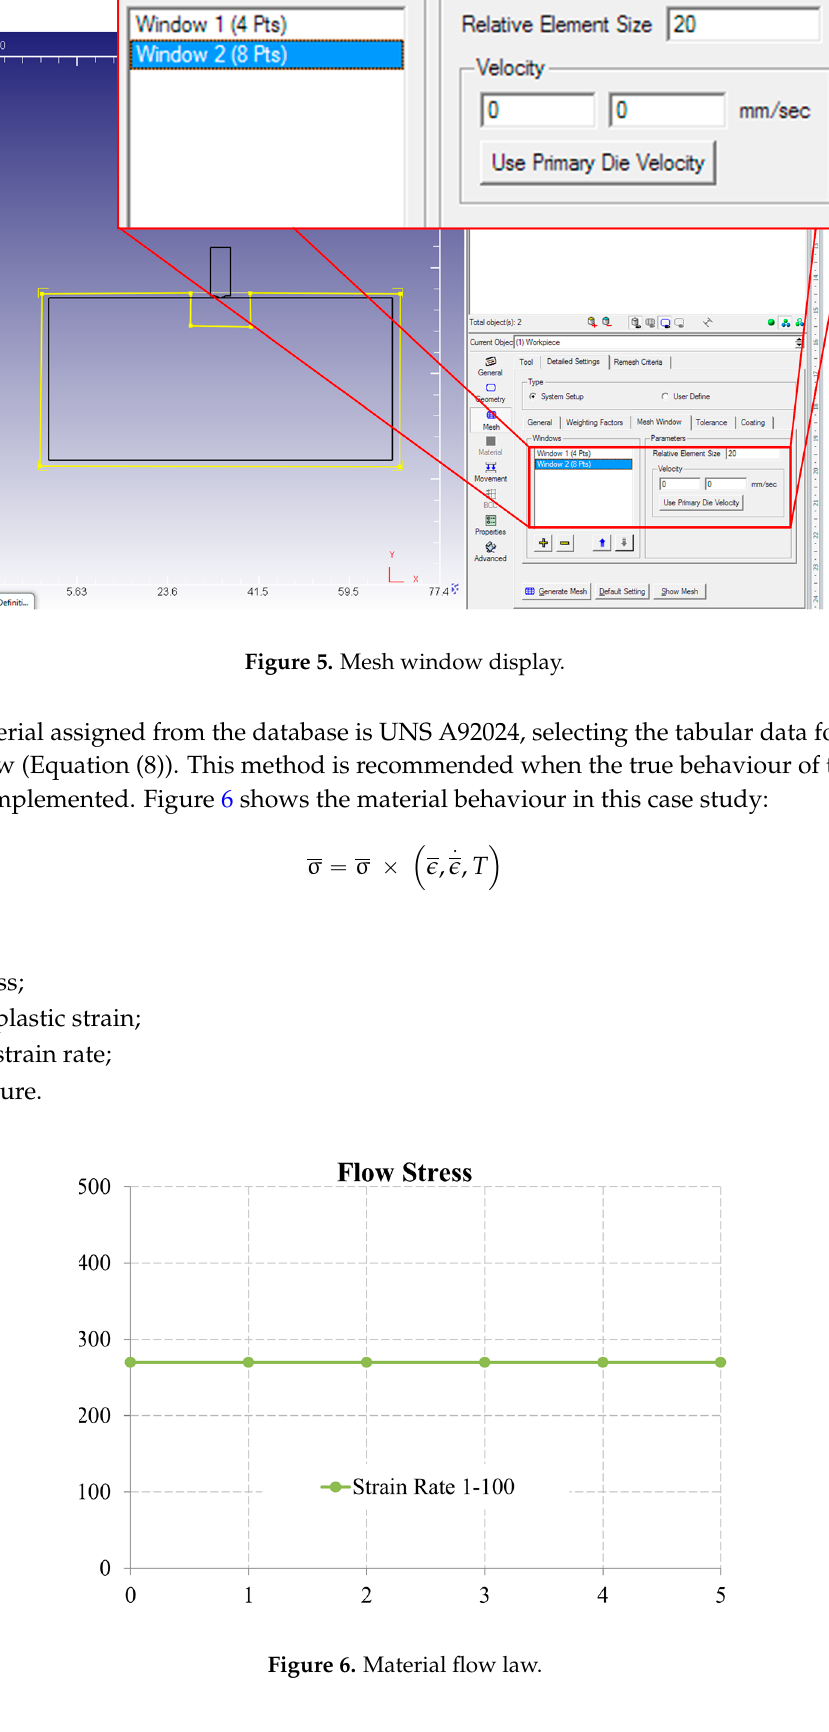
Table 1. General simulation settings.